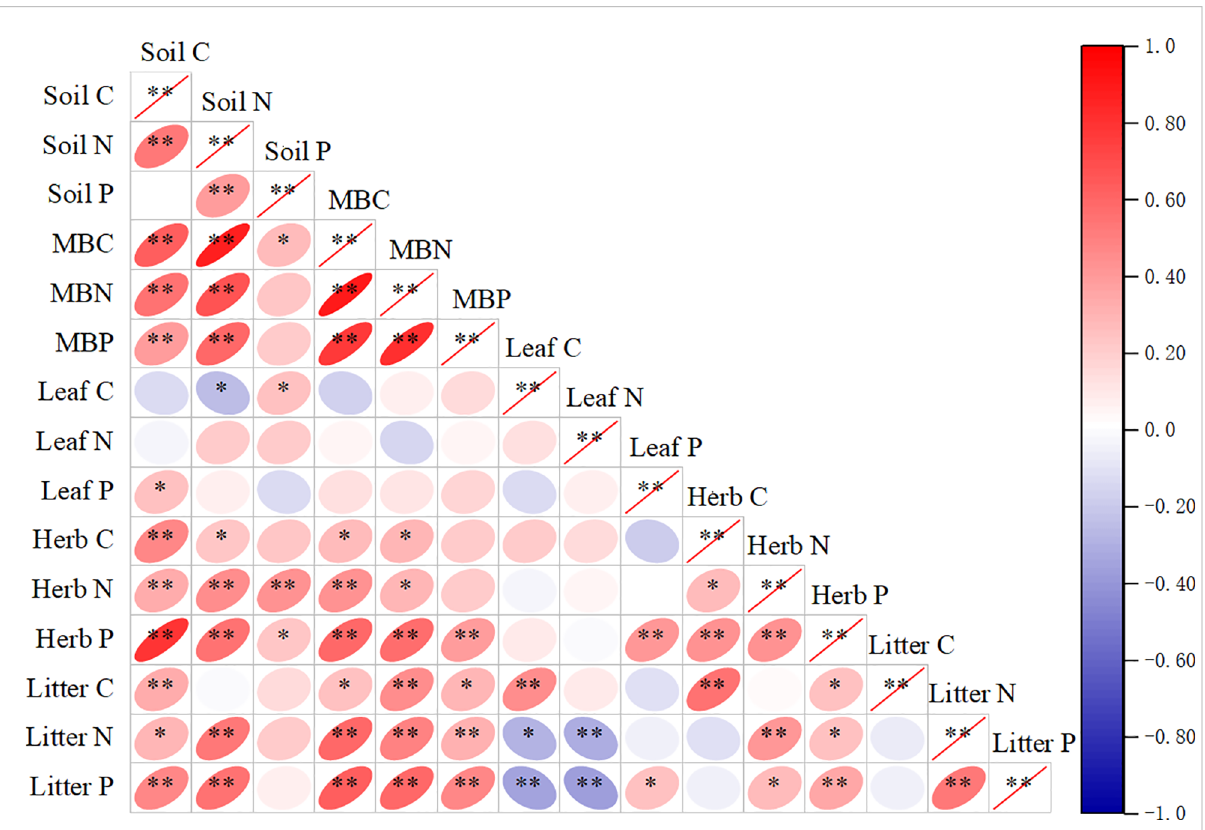
FIGURE 6 Correlations between soil, soil microbial biomass, Sophora moorcroftiana leaf, herb, and litter C, N, and P concentrations. Herb, understorey herb biomass. *P < 0.05, **P <